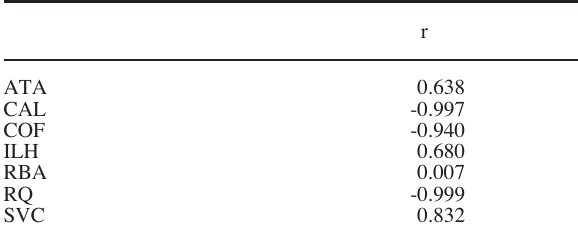
T ABLE 2. – Correlation coefficient (Pearson) between abundance of molluscs (N/100 g ADW) and algal dry weight (ADW) for each sampling site. Other abbreviations as in Figure 1.